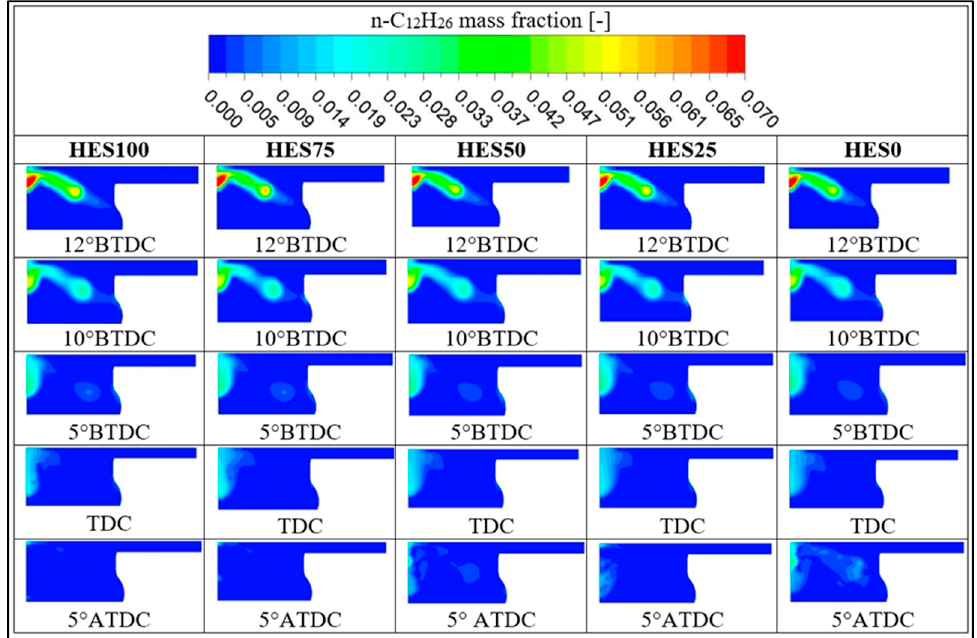
Figure 24. Diesel mass fraction distributions for the different HES cases .